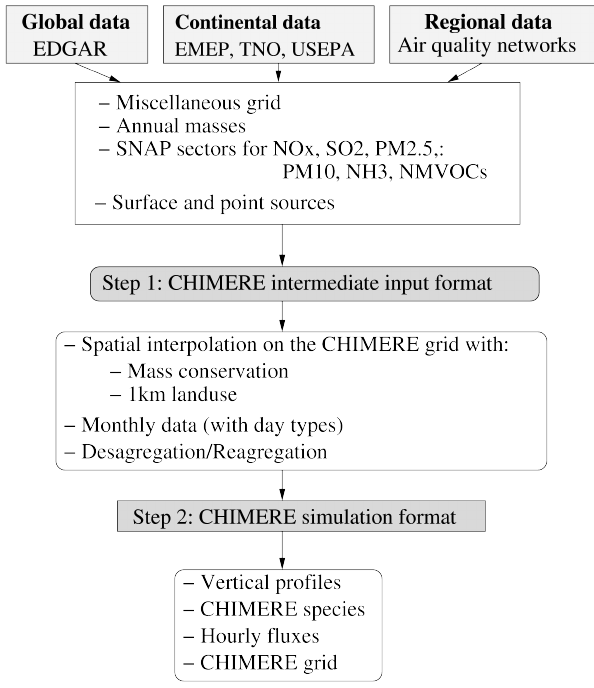
Fig. 9. General principle of the CHIMERE anthropogenic emis- sions procedure.